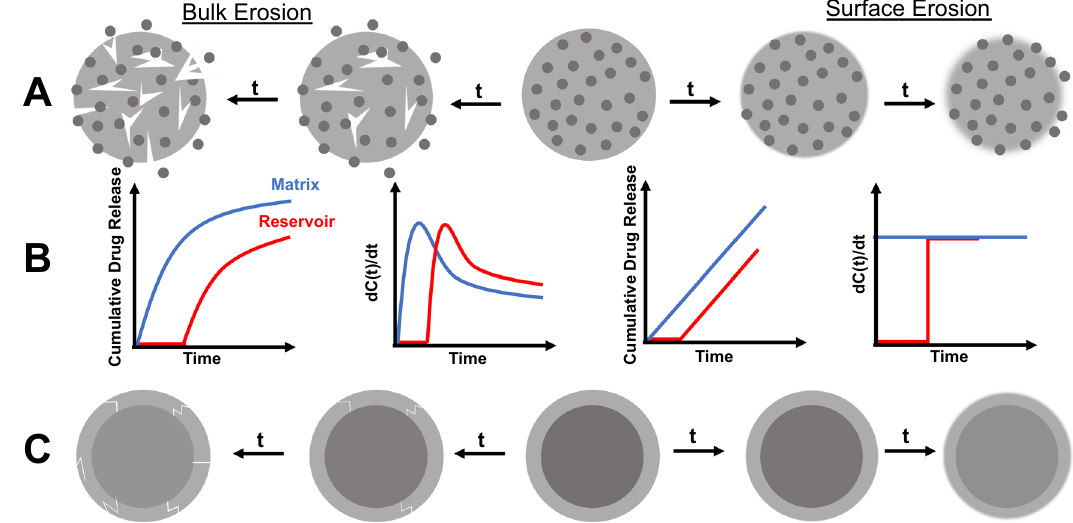
Fig. 4 Degradable polymeric systems can erode by different mechanisms depending on their chemical structure and mechanial properties. This factor, along with how the drug is incorporated into the matrix will ultimately impact how drug elution from the system occurs. Controlled delivery systems can incorporate drug in a matrix ( A , B ) or a reservoir ( B , C ) system. Depending on the application, this will alter the drug release from the system in a speci fi c manner. Reservoir systems are characteristic of a delayed release as the polymer surrounding the drug core degrades whereas matrix systems will depend more highly on the polymer-drug interactions among other factors ( B ). If solely based on polymer degradation, however, the release will either be more exponential (bulk erosion) or continual (surface erosion). Bulk erosion usually provides the system a “ burst ” release at early time points, followed by a continuous decrease in